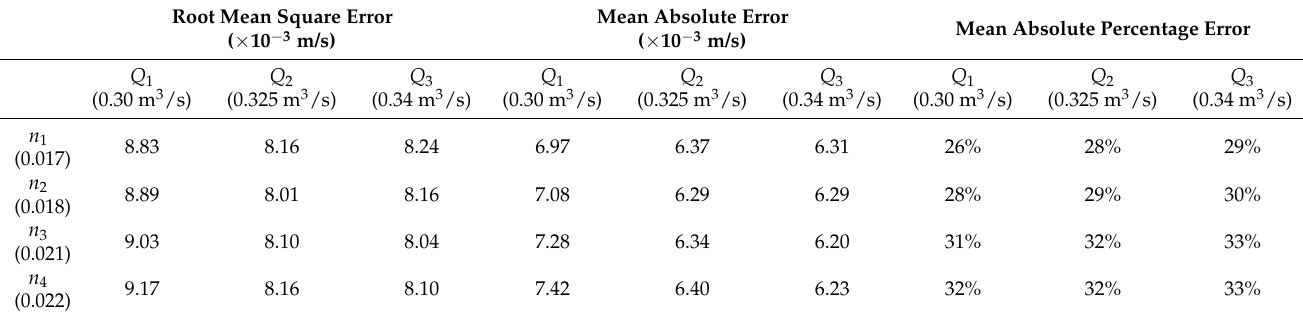
Table 5. Computed Versus Measured Velocity Error for Determining Discharge and Manning’s n.